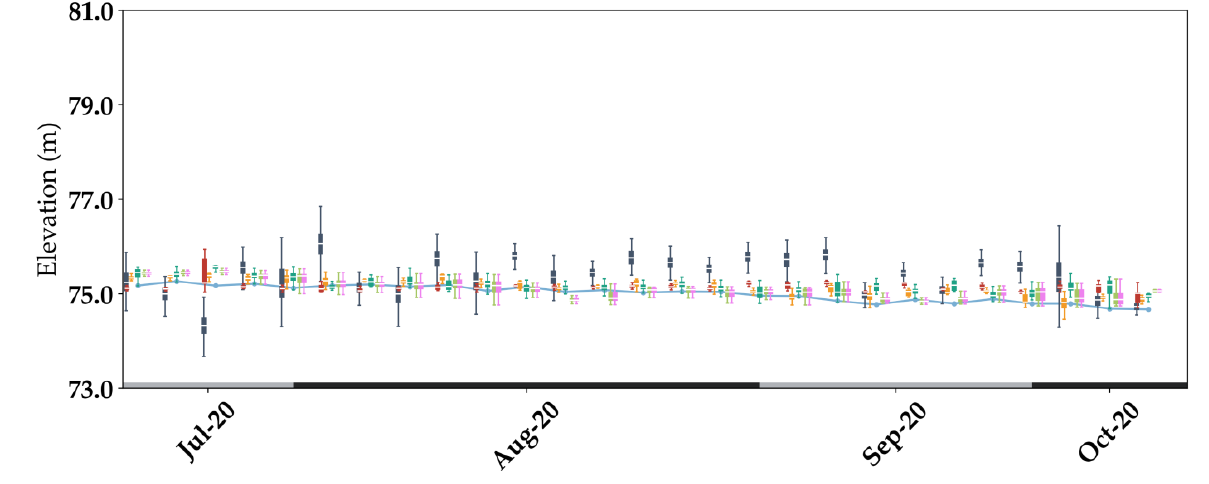
Figure A8. Boxplot by track of the original estimated elevations by GEDI over Lake Ontario and the five tested models presented in Section 3.1.3. The green line represents in situ elevations. 𝑅𝐹 𝐶𝑉 represents the 5-fold cross-validation results over Lake Ontario. 𝑅𝐹 𝐸𝑟𝑖𝑒 → 𝑂𝑛𝑡𝑎𝑟𝑖𝑜 , 𝑅𝐹 𝐻𝑢𝑟𝑜𝑛 → 𝑂𝑛𝑡𝑎𝑟𝑖𝑜 , 𝑅𝐹 𝑀𝑖𝑐ℎ𝑖𝑔𝑎𝑛 → 𝑂𝑛𝑡𝑎𝑟𝑖𝑜 , and 𝑅𝐹 𝑆𝑢𝑝𝑒𝑟𝑖𝑜𝑟 → 𝑂𝑛𝑡𝑎𝑟𝑖𝑜 represent the results of the models trained over Lakes Erie, Huron, Michigan, and Superior, respectively, applied over Lake Ontario.